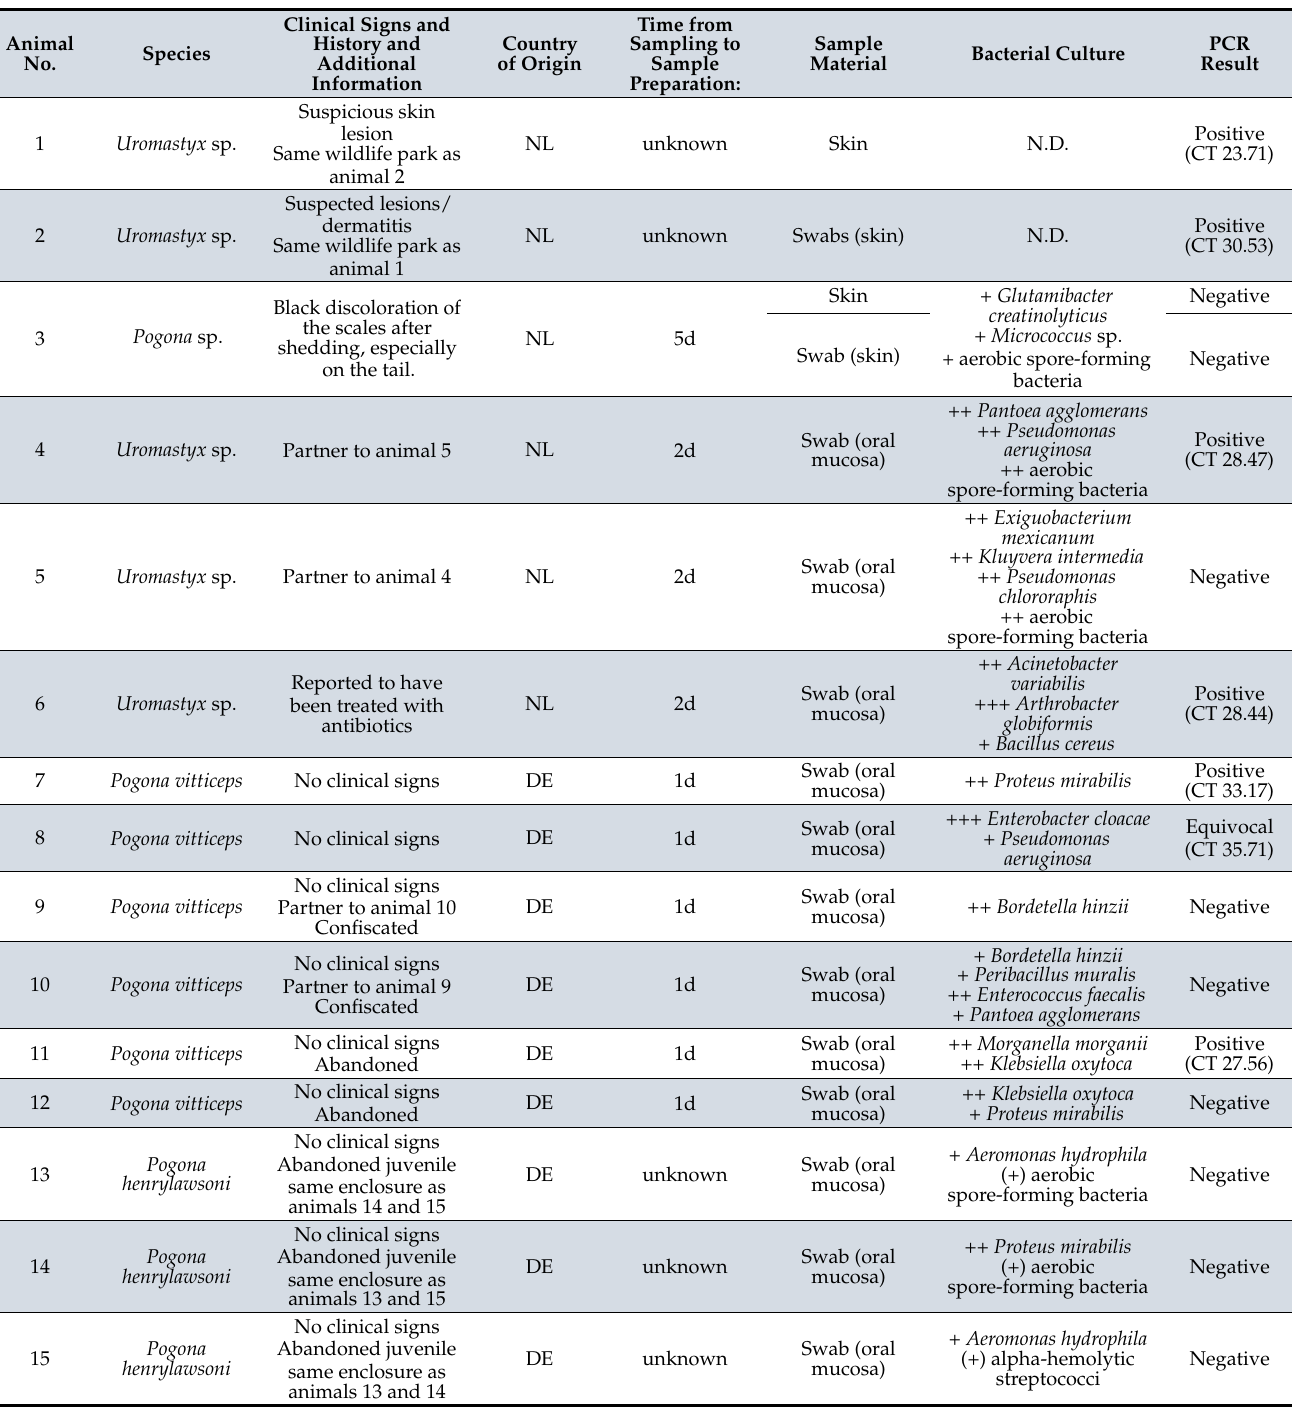
Table 4. Results of bacteriological culture and Devriesea agamarum PCR of clinical samples from 38